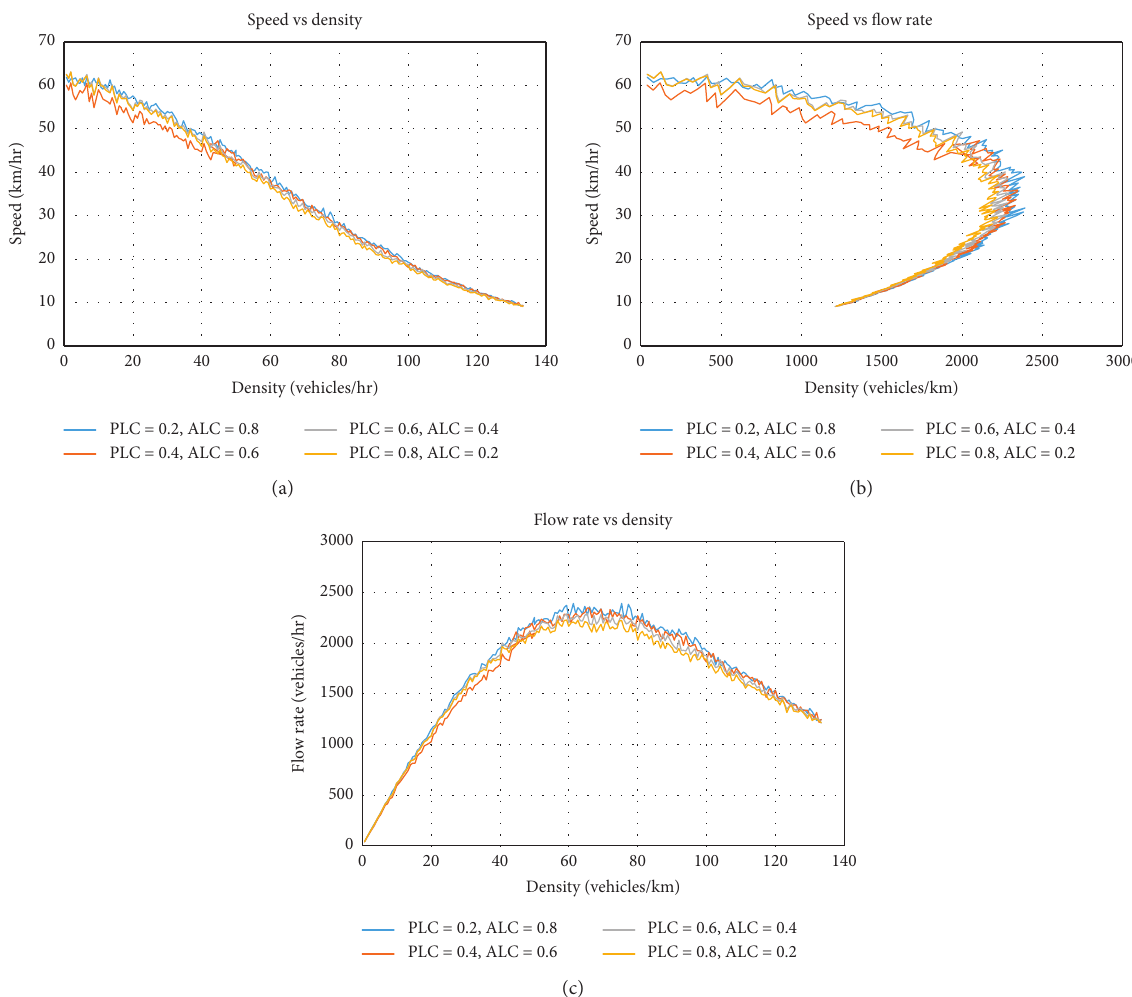
Figure 9: Traffic flow fundamental diagrams for different compositions of AC, MC, AB, and MB with different values of PLC and